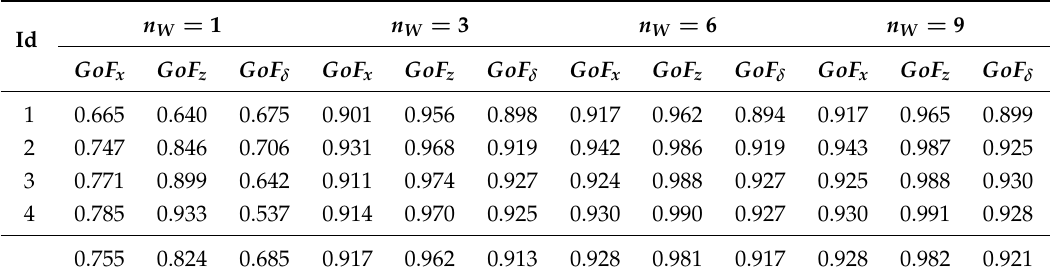
Table 3. GoF results of the KF observer for each tuning wave for different number of frequencies n W . The last row stores the mean